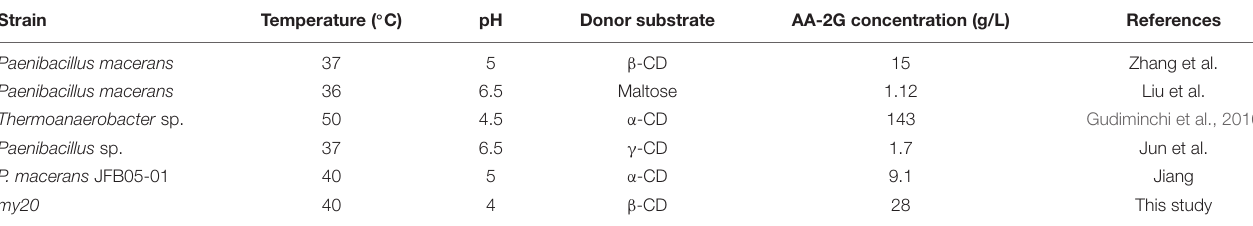
TABLE 4 | Optimum reaction conditions of 2- O - α - D -glucopyranosyl- L -ascorbic acid (AA-2G) synthesis by CGTase from different strains.